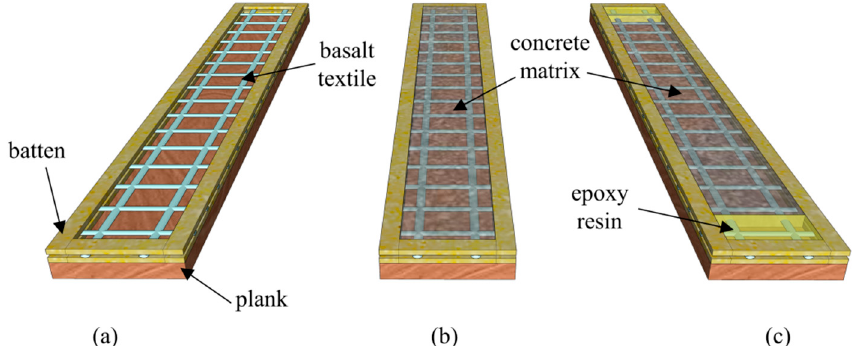
Figure 3. Fabrication of TRC coupons: ( a ) wooden molds; ( b ) casting concrete matrix; and ( c ) casting concrete matrix and epoxy resin in the middle and end zones, respectively.